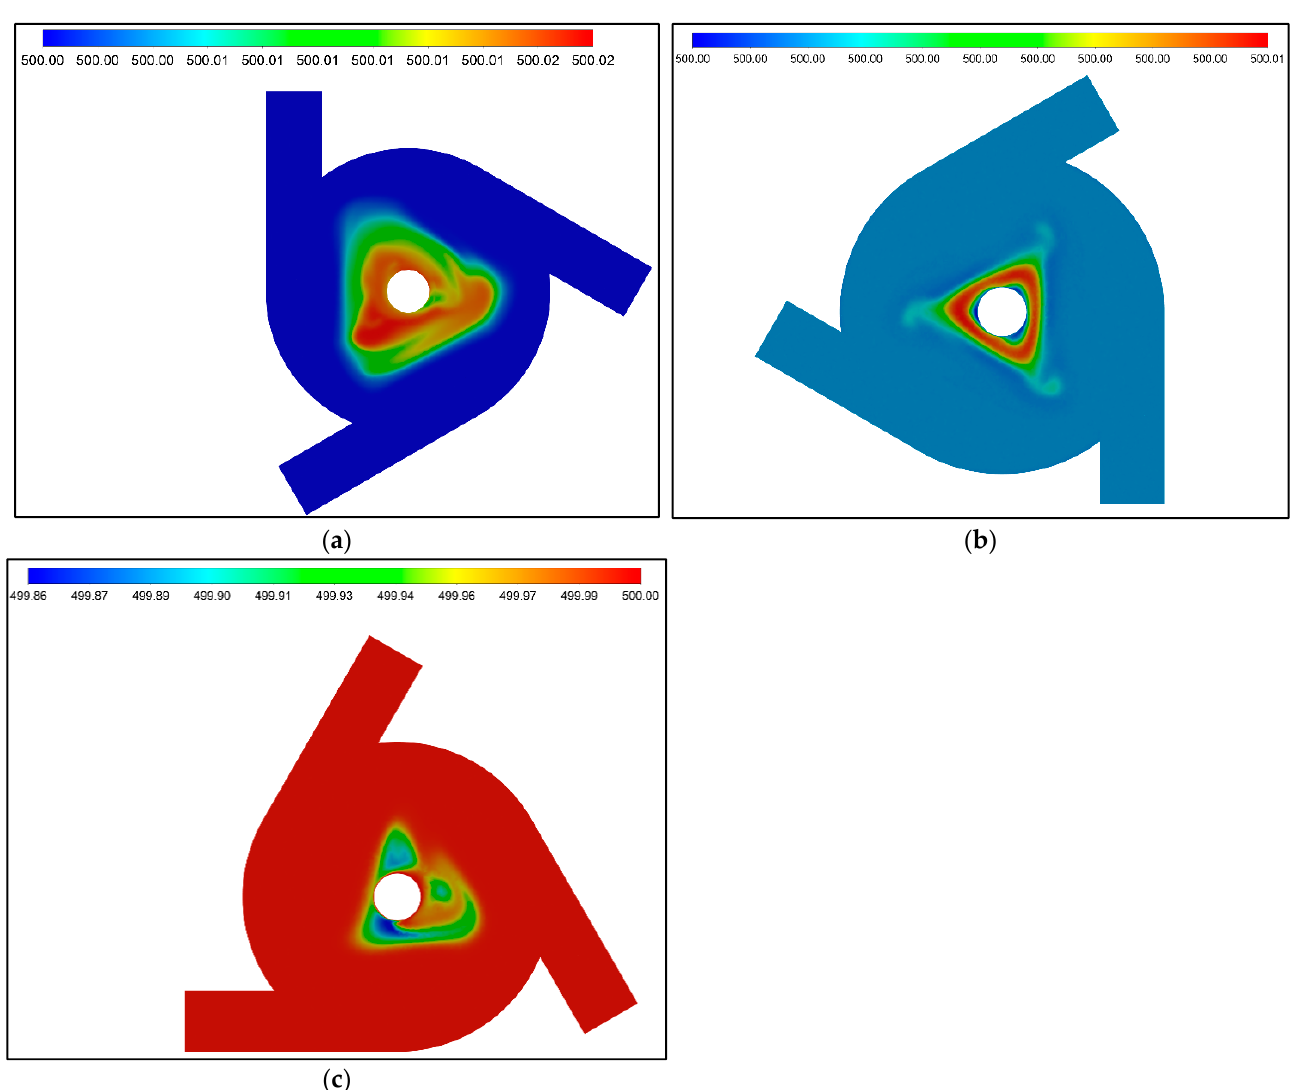
Figure 5. Total temperature contour obtained for SVT with ( a ) inviscid Ar ; ( b ) inviscid CO 2 ; and ( c ) inviscid air.